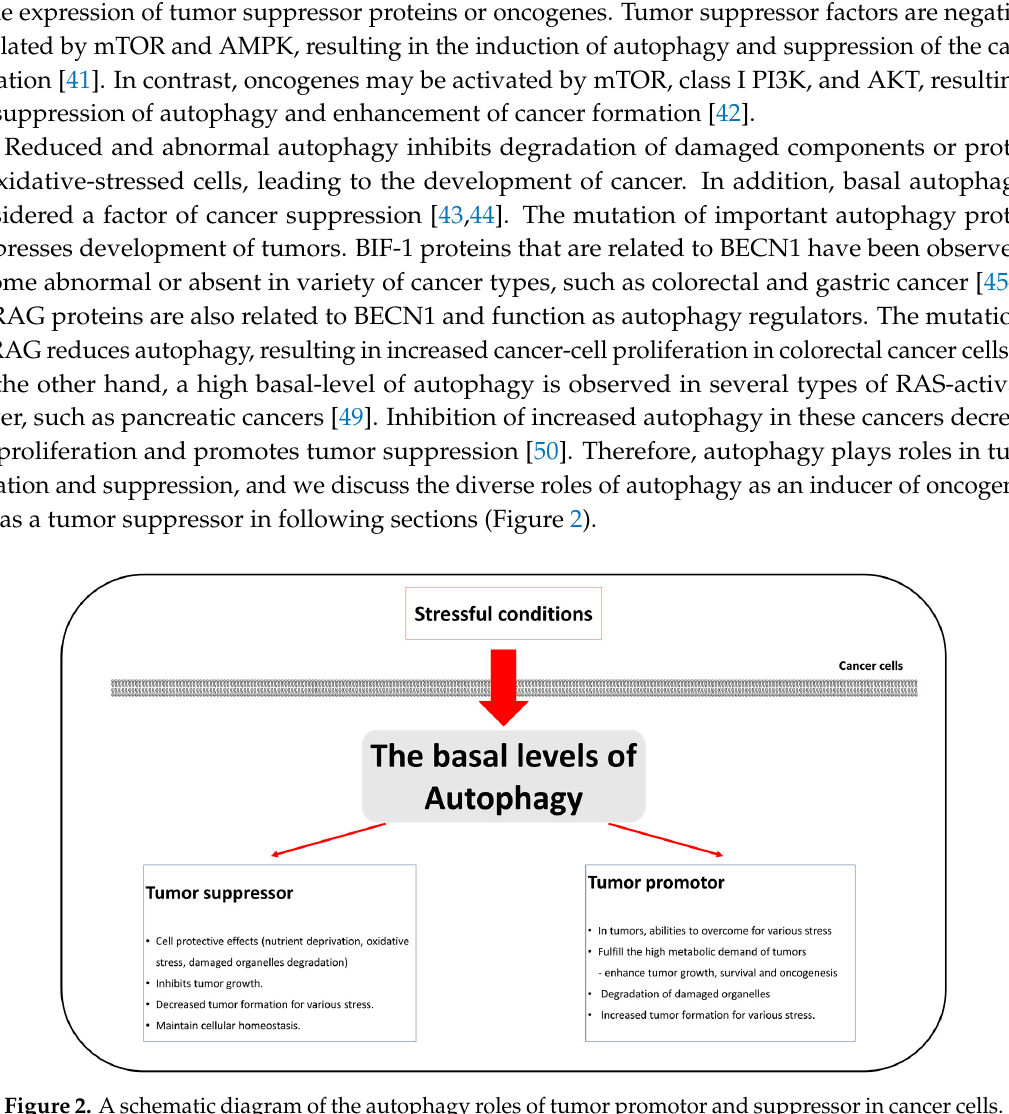
Figure 2. A schematic diagram of the autophagy roles of tumor promotor and suppressor in cancer